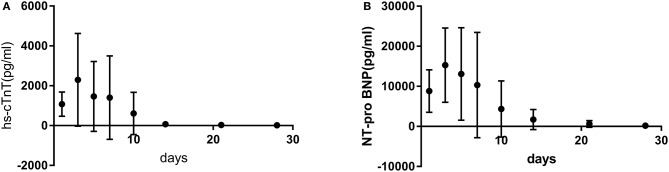
The trend of hs-cTnT (A) and NT-pro BNP (B) with the course of disease.